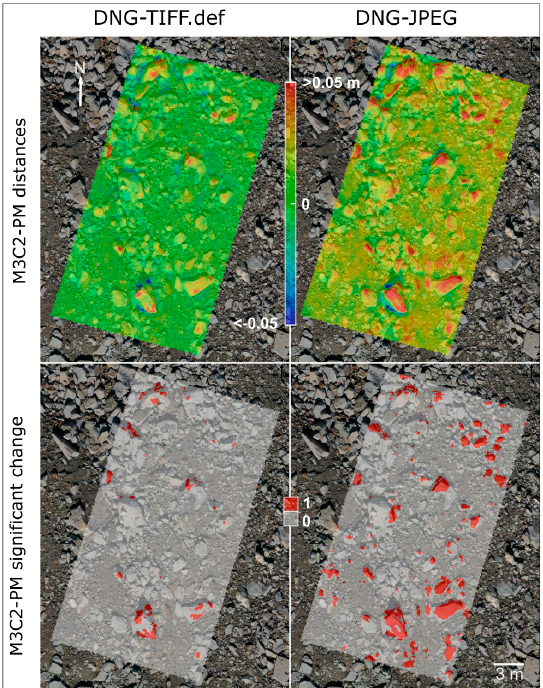
Figure 7. Detail of the M3C2-PM comparison between image sets (sector 3). M3C2-PM distances less than -0.05 m are shown in blue and distances greater than 0.05 m are shown in red. M3C2-PM significant changes are shown in red.